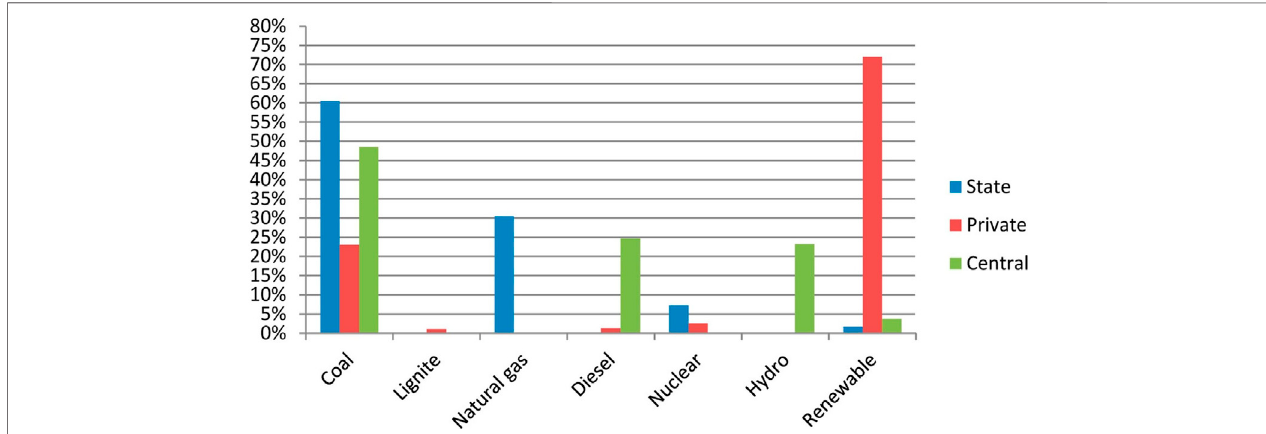
Frontiers in Energy Research |